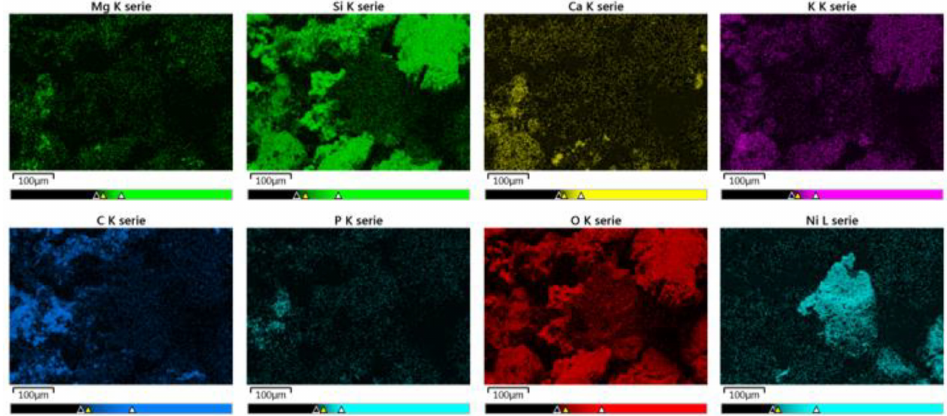
Figure 13. EDX analysis of solid deposits from experiment 5.